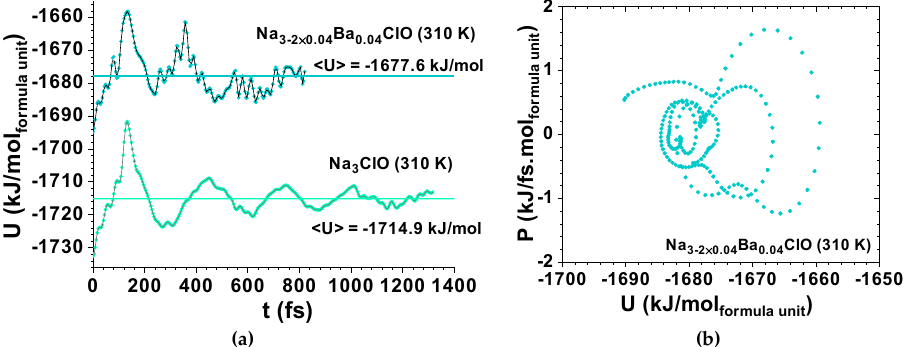
Figure 7. Ab Initio Molecular Dynamics for Na-glass ferroelectric-electrolyte showing decoher- ence; ( a ) potential energy vs time for Na 2.92 Ba 0.04 ClO at 310 K; the calculated specific heat is C v’ = 0.442 kJ/kg K and potential energy vs time for Na 3 ClO at 310 K; the calculated specific heat is C v’ = 0.457 kJ/kg K; ( b ) phase portrait of Na 2.92 Ba 0.04 ClO for power vs potential energy showing back and forth between two double-wells described by a van der Pol-Duffing oscillator model as the one in Figure